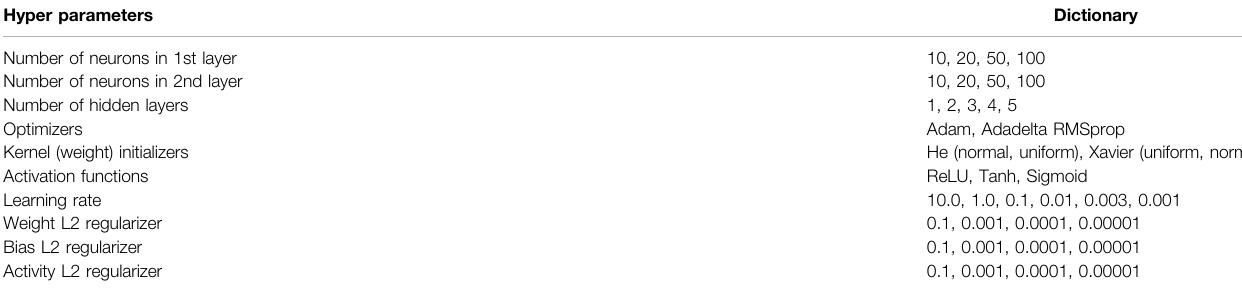
TABLE 4 | List of considered hyper-parameters. Hyper